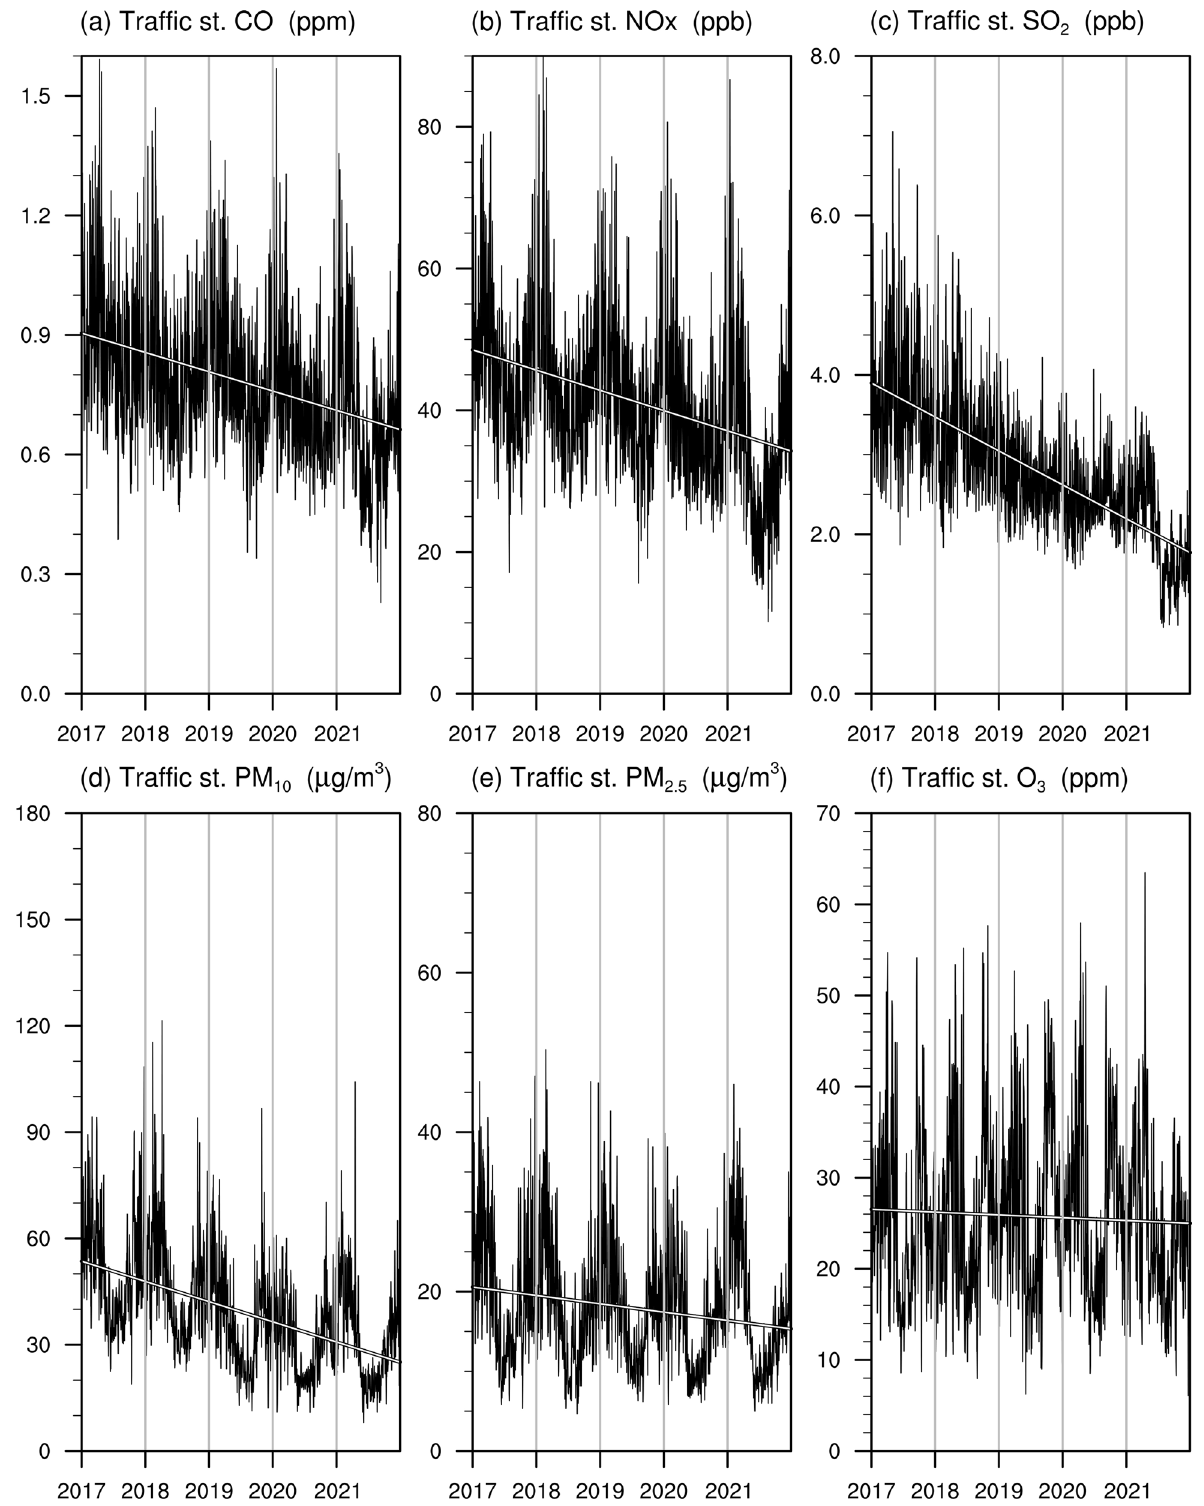
Fig. 5 Same as Fig. 4 but monitored by the traffic